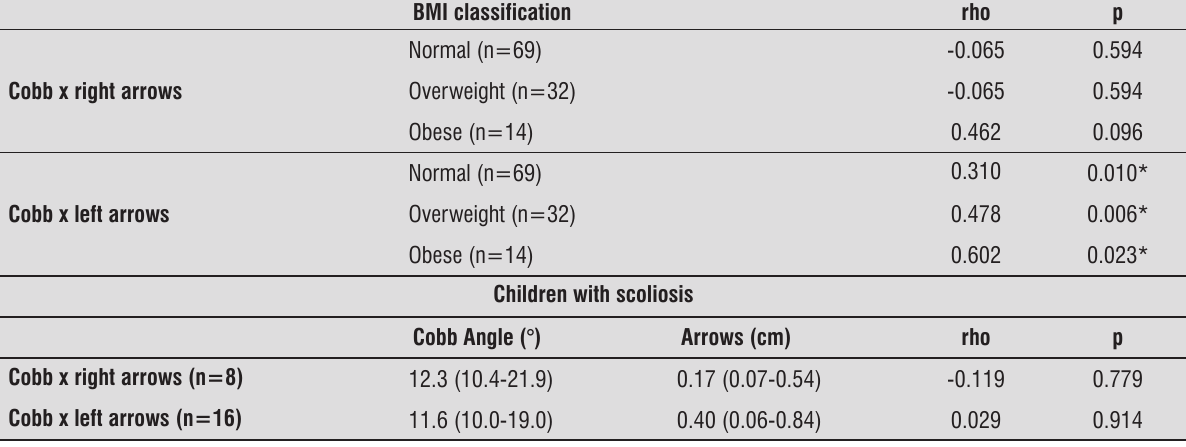
Table 3 - Results of correlation between scoliosis arrows of Vert 3D system and Cobb angles in different nutrient profiles for children with scoliosis